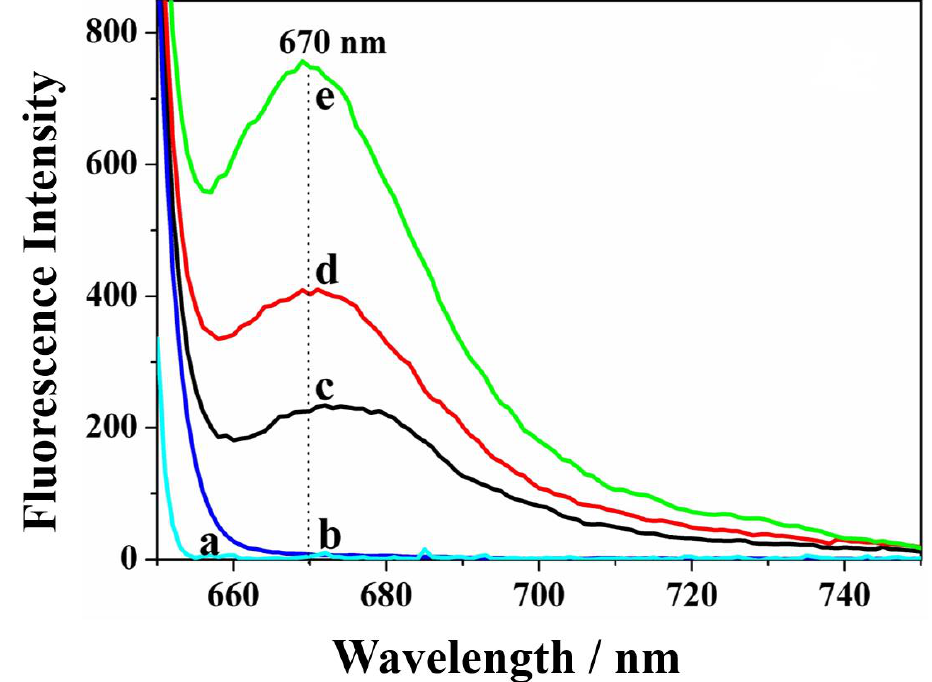
Figure 1. The fluorescence spectrum of the developed sensing system is collected in a blank control sample (curve “a”); in the presence of aptamer DNA, an MB, polymerase, and nicking endonuclease, but without PDGF-BB (curve “b”); in the presence of PDGF-BB, aptamer DNA, and an MB (curve “c”); in the presence of PDGF-BB, aptamer DNA, an MB, and polymerase (curve “d”); and in the presence of PDGF-BB, aptamer DNA, MB, polymerase, and nicking endonuclease Nt.BbvCI (curve “e”). The reaction is in an NEB buffer (pH 7.9) at 37 ◦ C for 2 h containing 1 µ M aptamer DNA, 1 µ M MB, 2.5 µ M primer, 100 ng/mL PDGF-BB, 1 U/ µ L Klenow Fragment exo-, 2 mM dNTPs, and 1 U/ µ L Nt.BbvCI .